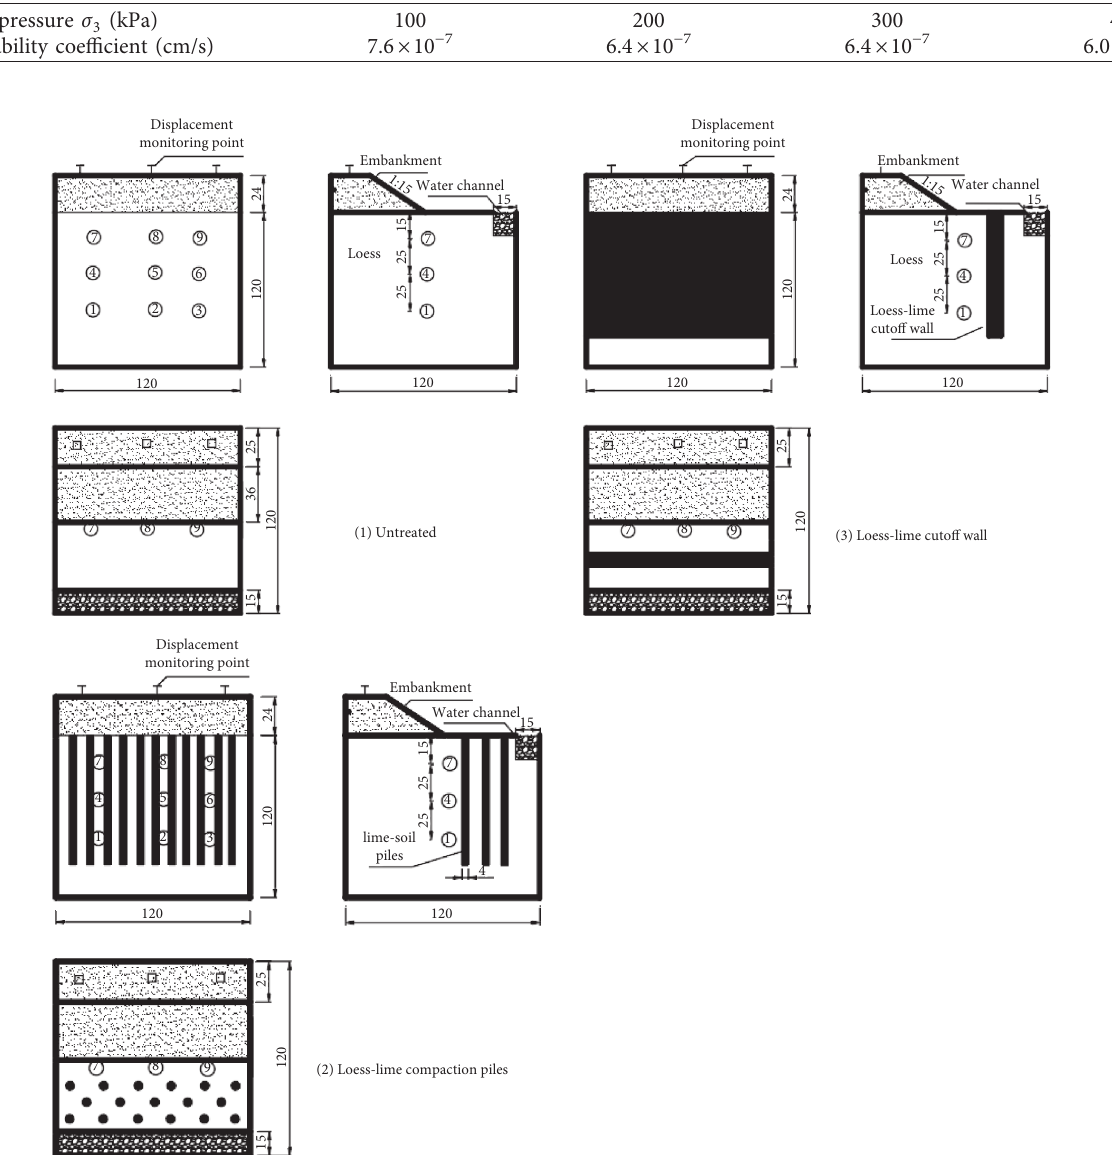
Figure 2: Schematic diagram of tests A, B, and C. Note: points 1 to 9 are the locations of moisture